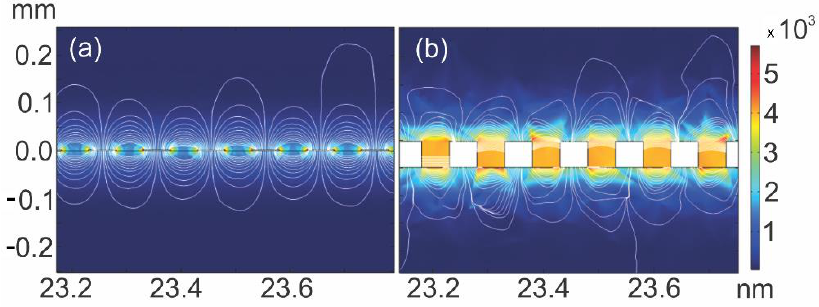
Figure 3. Electric field lines for the interdigitated electrode with ( a ) 0.00254 nm and ( b ) 0.04754 nm.